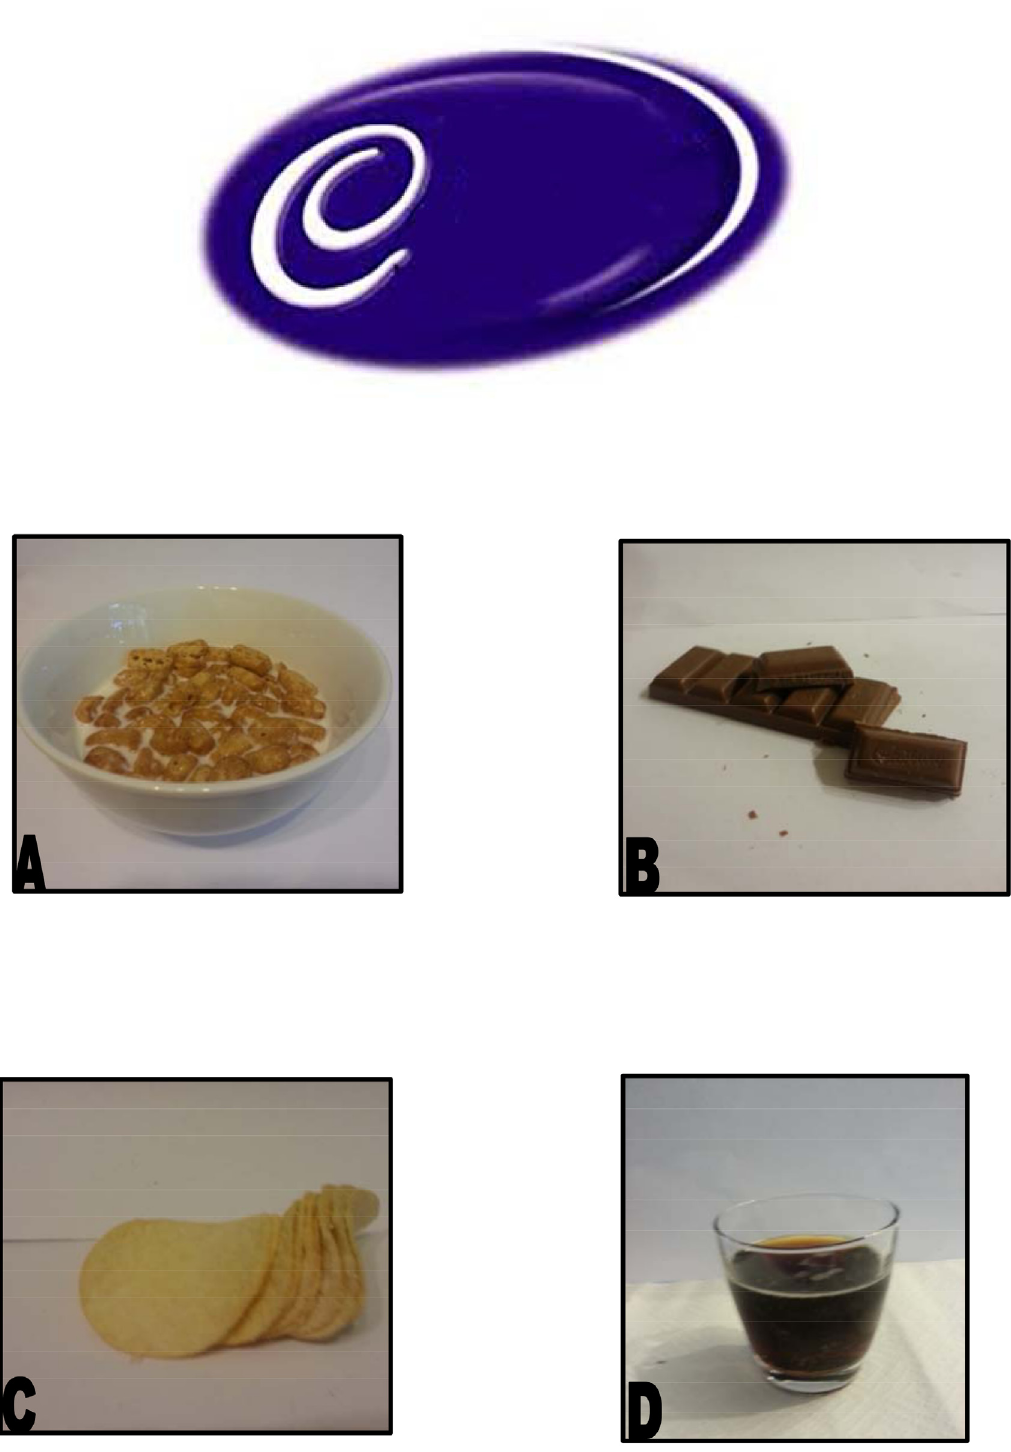
Fig 1. Sample flash